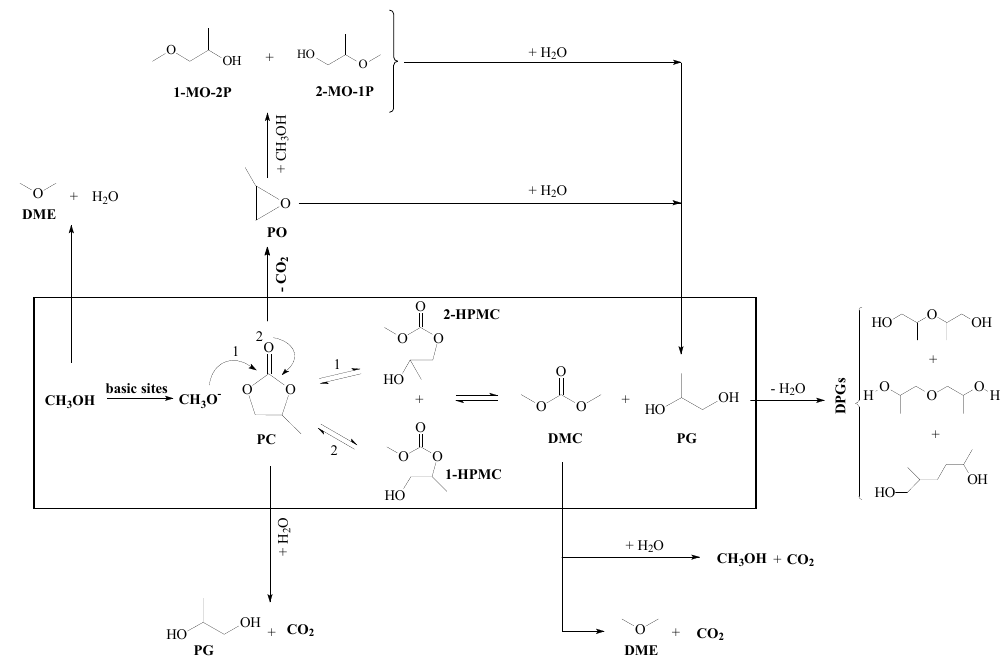
catalysts,Table S2: Weight losses from TG analysis for the prepared oxide